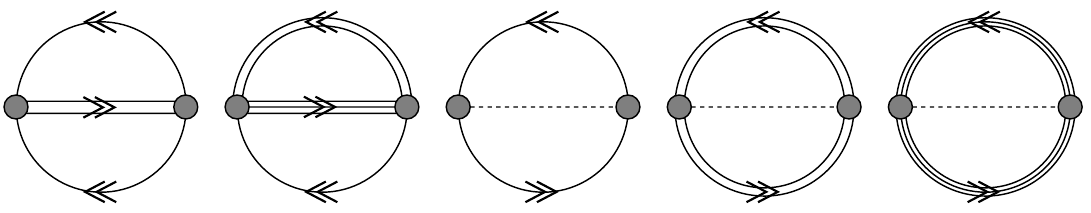
Figure 8. The contributions to the Φ functional for the quark-meson-diquark-baryon system.